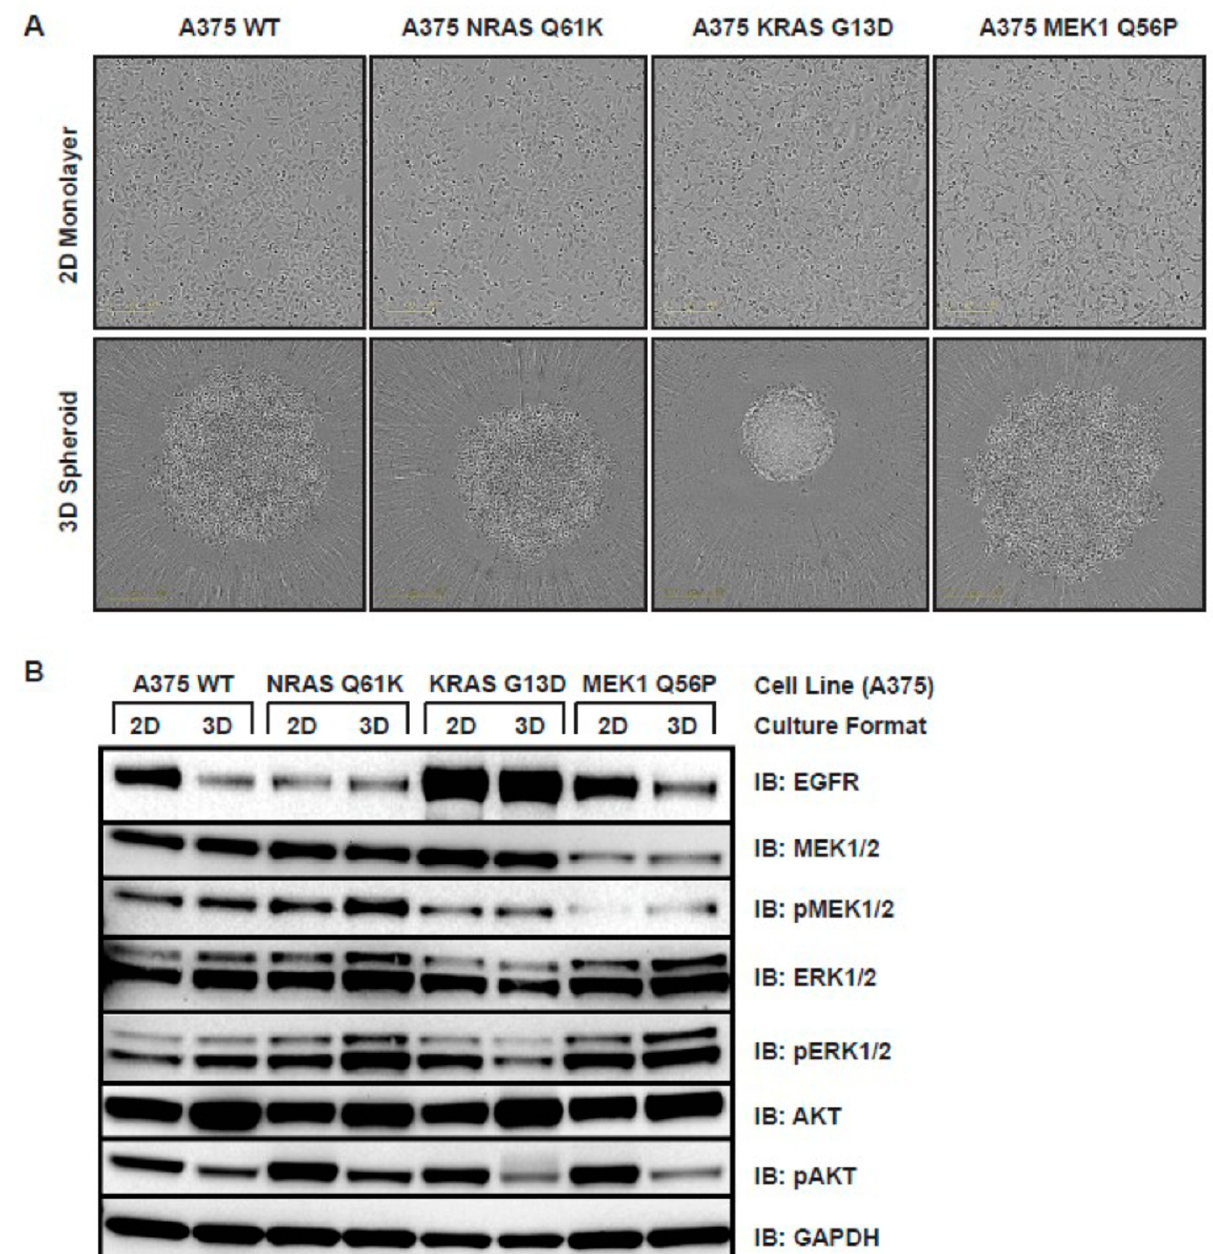
Figure 3. Effect of tissue culture format on EGFR pathway signaling in drug-resistant melanoma models. ( A ) A375 WT, NRAS Q61K, KRAS G13D, and MEK1 Q56P cells growing in a 2D monolayer